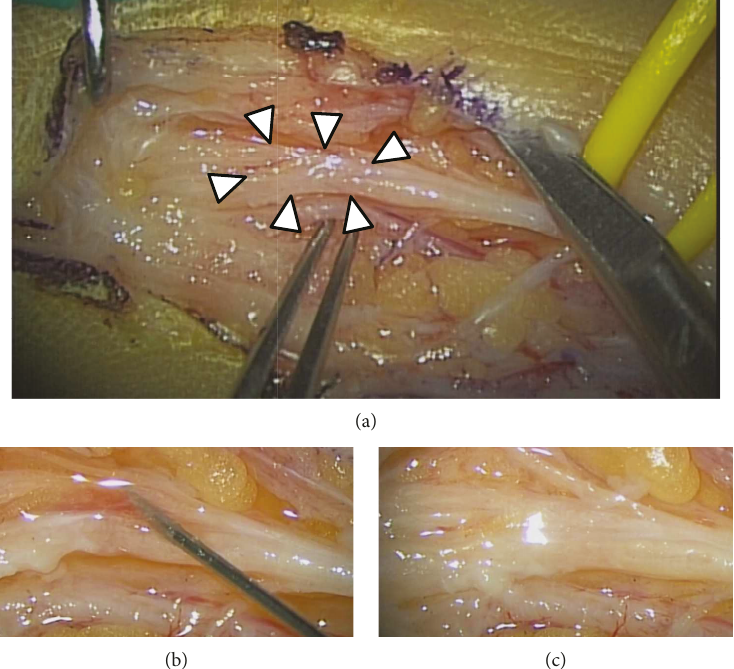
Figure 4: Intraoperative fi ndings. (a) After neurolysis, severe adhesion was observed at the scar area (arrowhead). (b) Intrafascicular injection of platelet-rich plasma (PRP) using a 25-gauge needle. (c) After PRP injection.